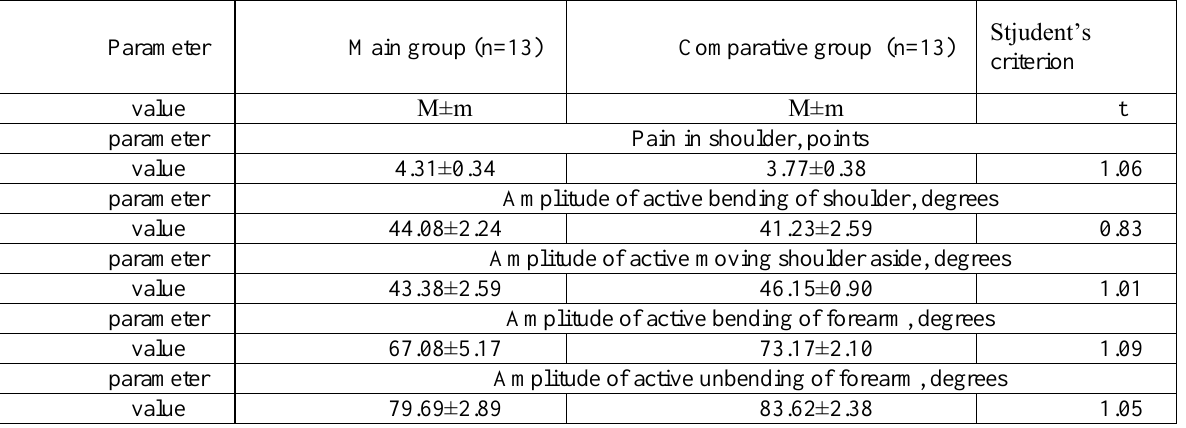
Comparing of tested indicators of main and control groups before and after research